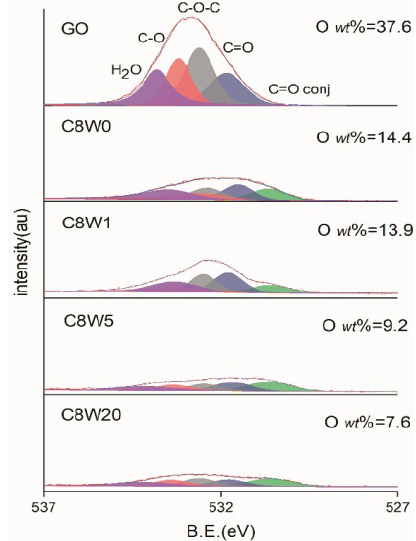
Figure 6. O1s XPS fitting curves of different microwave processing durations.